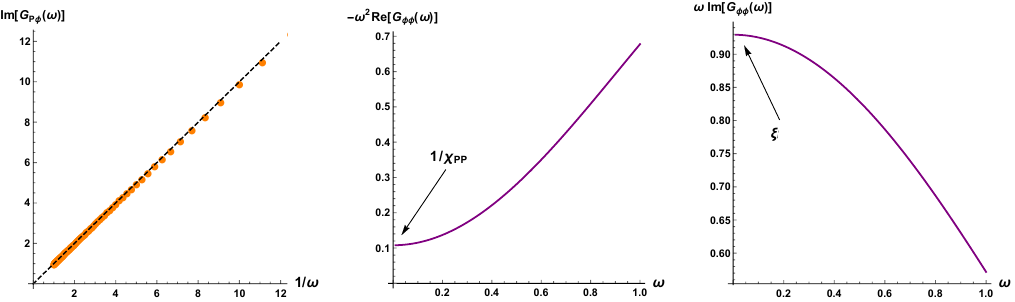
Figure 3 . The correlator of the Goldstone operator (cid:8) as a function of the frequency for m=T = 1 and N = 3. Left: the imaginary part of the mixed correlator h P (cid:8) i . The dashed line guides the eye towards the (cid:24) 1 =! behaviour. Center: the real part of the h (cid:8)(cid:8) i correlator multiplied by ! 2 . The zero frequency value coincides with the inverse of the momentum susceptibility. Right: the imaginary part of the h (cid:8)(cid:8) i correlator multiplied by the frequency ! . The zero frequency value coincides with the parameter (cid:24)